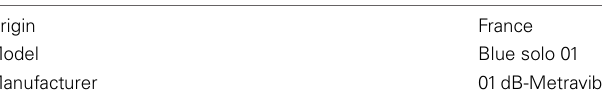
Table 1 | Brief information of integrating sound level meter used for the study.